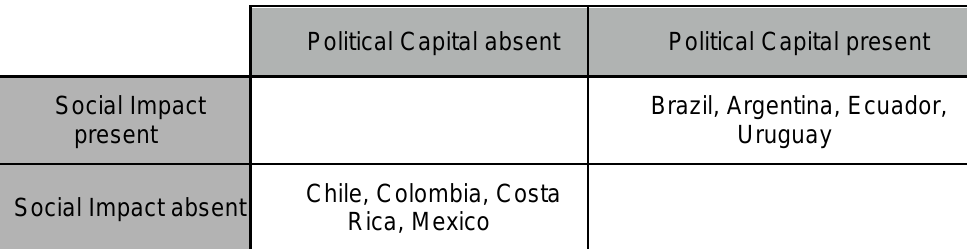
Table 5. Cross Tabulation Political Capital and Social